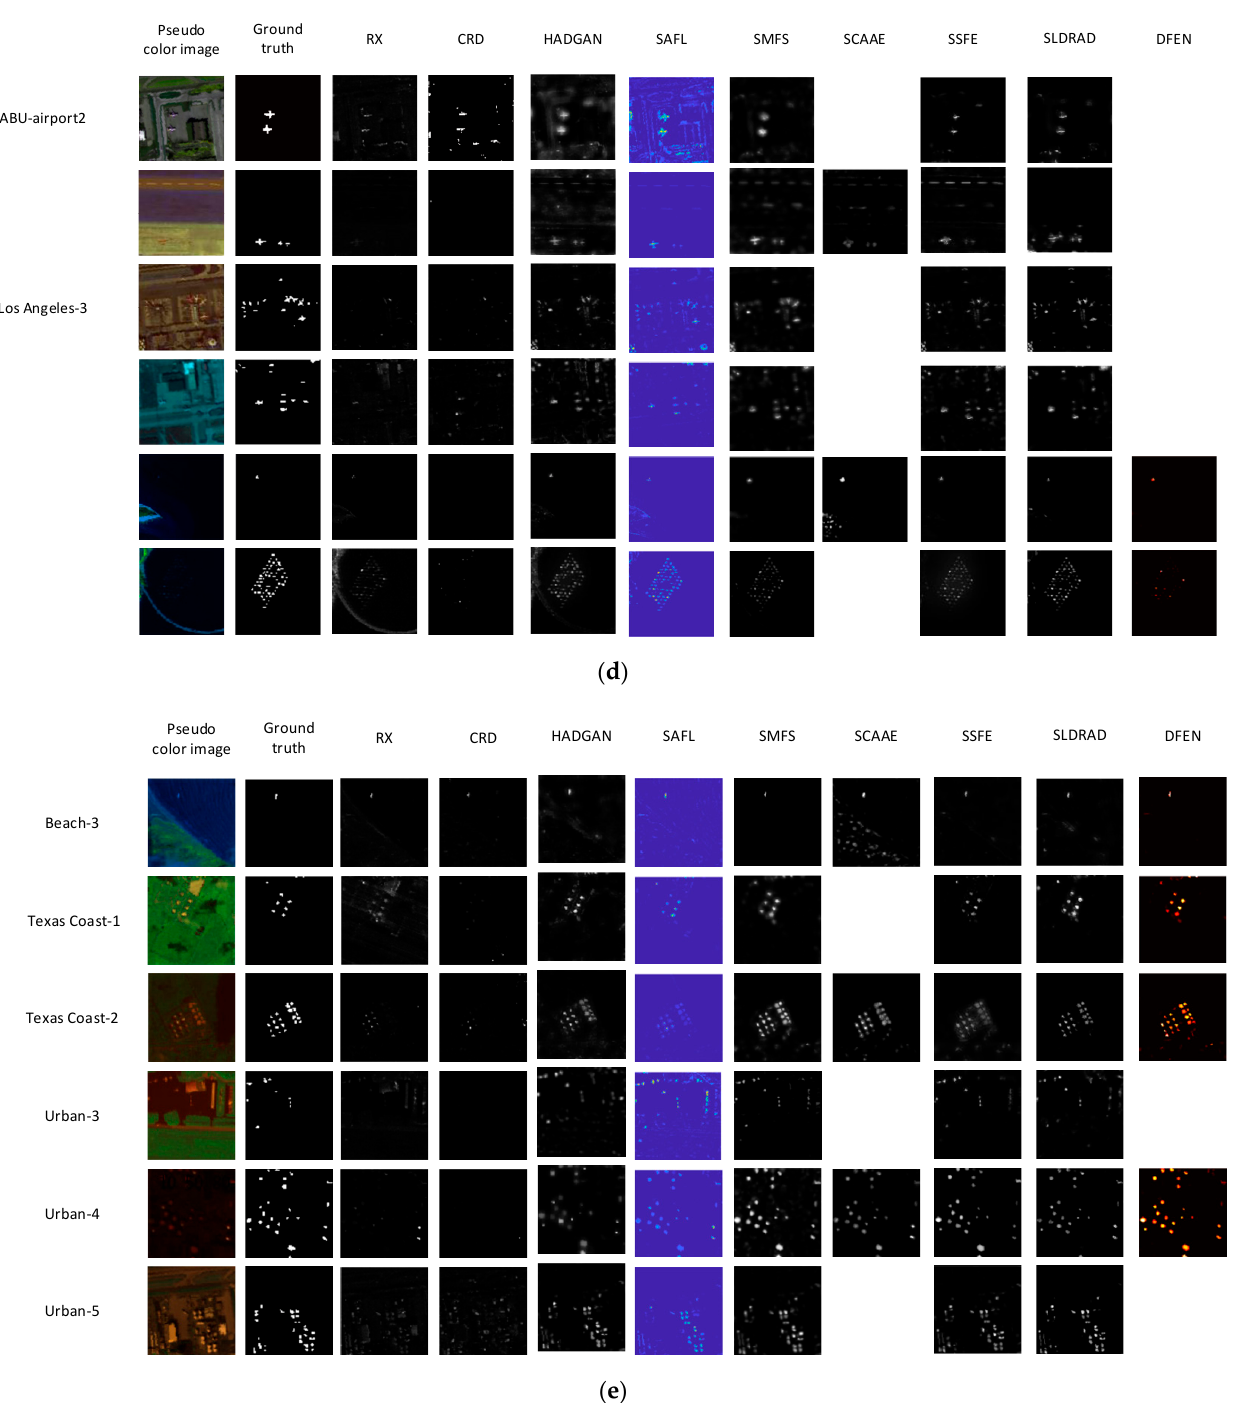
Figure A1. ( a – e ) Anomaly detection effects of different methods on different hyperspectral datasets.